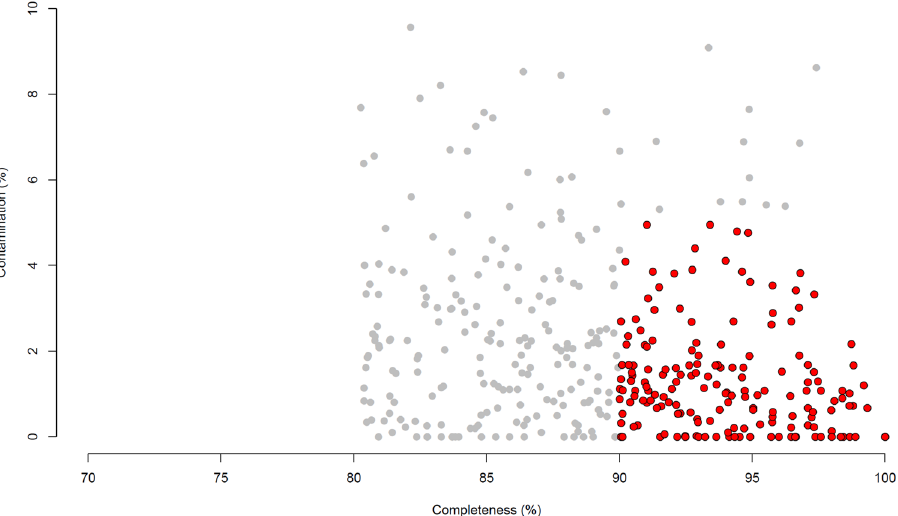
Figure 1. Contamination and completeness (defined by CheckM software) of 391 dereplicated metagenome- assembled-genomes from rumen samples. Grey: genomes which are 80–90% complete with 5–10% contamination. Red: genomes which are > 90% complete with < 5% contamination.